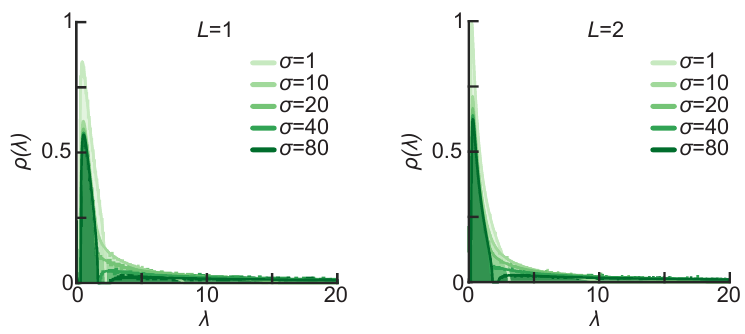
Figure 2: Eigenvalue densities for structured Wishart product matrices for depths L = 1 ( left ) and L = 2 ( right ) of width α structure is as described in the main text, with M Σ and varying signal eigenvalues σ , indicated by shades of green. Solid lines show the result of solving equation (38) numerically, while shaded areas show the results of numerical eigendecompositions of matrices of size n empirical histogram is obtained for a single realization of the random